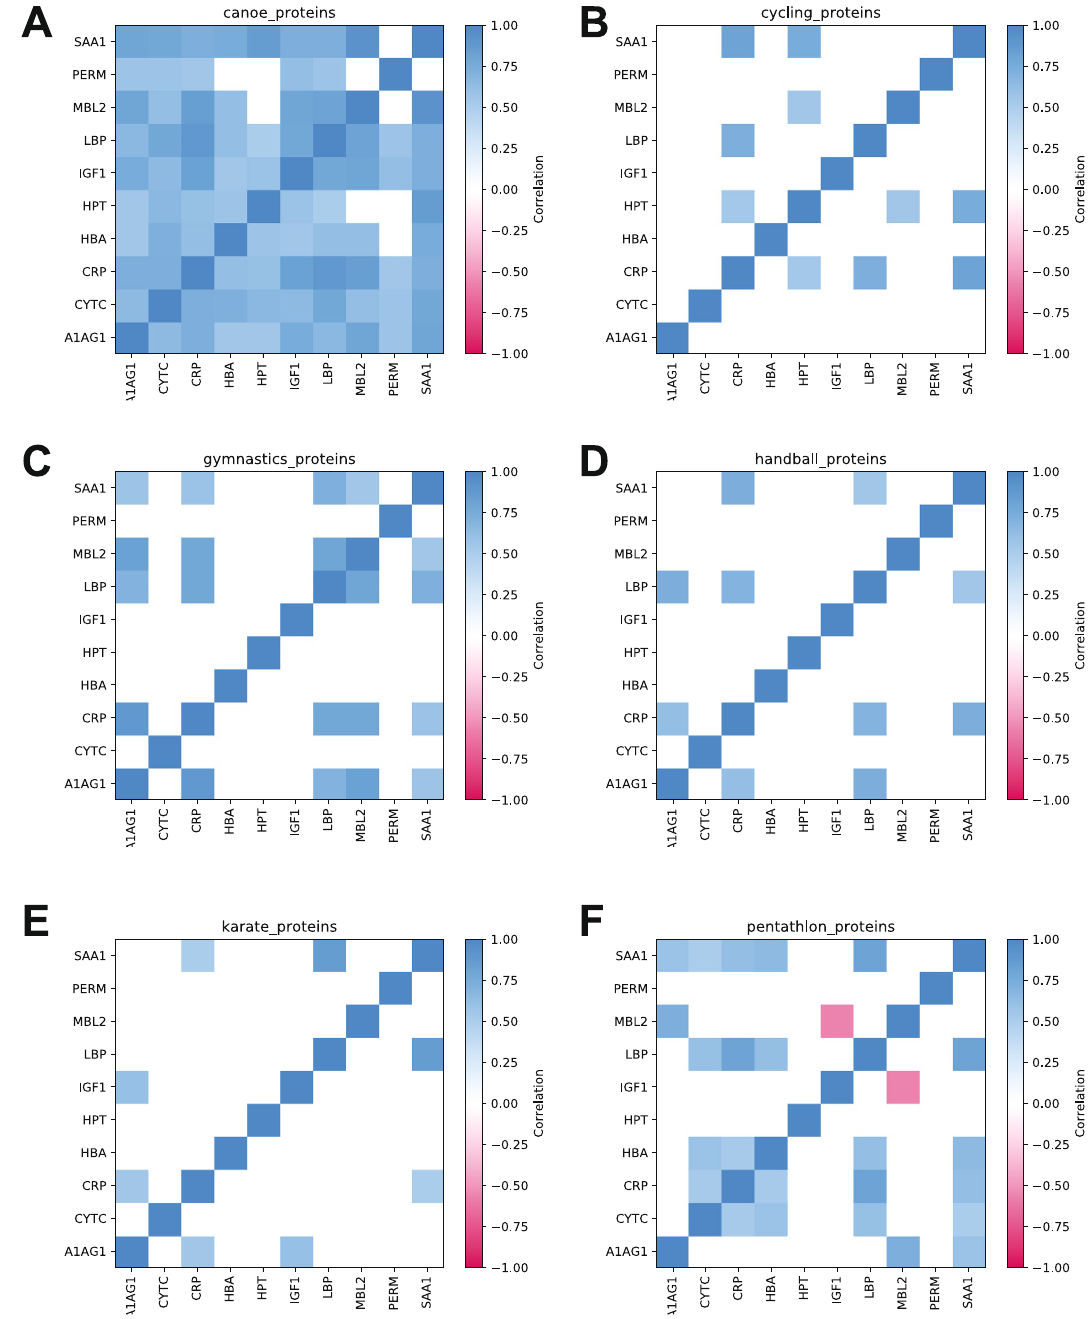
Figure 4. SAA1 and CRP are strongly correlated. LBP and CRP are also strongly correlated. Matrix of pairwise correlations among proteins for ( A ) canoeing (n = 58); ( B ) cycling (n = 34); ( C ) gymnastics (n = 84); ( D ) handball (n = 139); ( E ) karate (n = 63) and ( F ) modern pentathlon (n = 111). The positive (blue) and negative (red) correlations at p value < 0.001 are shown. Protein correlations r s > 0.5. Full data are presented in Supplementary Material 1. Alpha-1-acid glycoprotein—A1AG1; Albumin—ALBU; Cystatin C—CYTC; C-reactive protein CRP; Hemoglobin beta chain—HBA; Haptoglobin—HPT; Insulin-like growth factor 1—IGF1; Lipopolysaccharide binding protein—LBP; Mannose-binding lectin—MBL2; Myeloperoxidase—PERM and Serum amyloid A1—